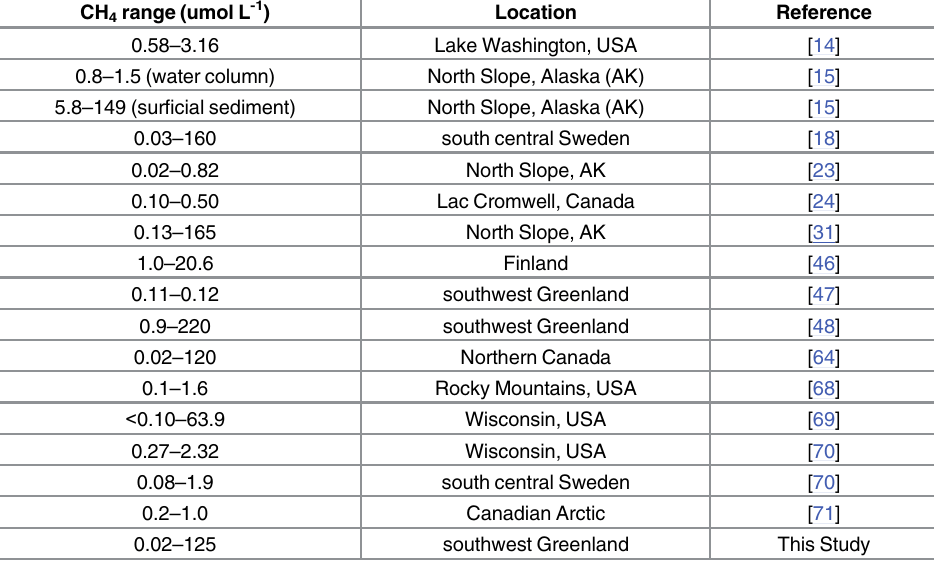
tion experiments, so the results are likely influenced by factors not addressed in this study. Our data are also consistent with values measured in small lakes adjacent to our study areas in southwest Greenland [47, 48]. The highest values of methane in southwest Greenland occur under the ice [48] or during spring turnover [49]. cant regional differences in not only methane, but also the physico-chemical and biological fac- tors that ultimately were related to its availability. The Greenland Ice Sheet is a major feature of Table 5. Ranges of methane in freshwater lakes across the Northern